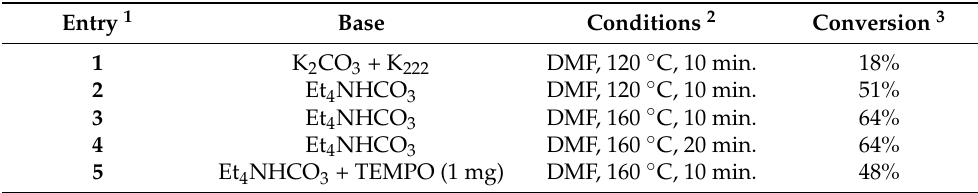
Table 2. Deprotection using trifluoroacetic acid (TFA) in a mixture of dioxane and water at 120 ◦ C for 10 min was carried out after a solvent exchange realized by solid phase extraction on a Sep Pak ® C18 cartridge (Table 2, entry 1). We chose to add water to accelerate the reaction, as it is known to catalyze Boc deprotection at high temperatures [37]. In these conditions, only partial deprotection of compound [ 18 F]8 was observed, and conversion into [ 18 F] (R,S) -crizotinib was only 47%. Aiming at simplifying the whole radiosynthesis process, deprotection was realized in one pot after the radiofluorination step, in DMF. Using hydrochloric acid (3M) at 120 ◦ C for 10 min also resulted in partial deprotection and a conversion of 72% (Table 2, entry 2). Complete deprotection of all Boc groups was finally realized using HCl (3M) in DMF at 160 ◦ C for 10 min to reach a conversion above 99% into [ 18 F] (R,S) -crizotinib (Table 2, entry